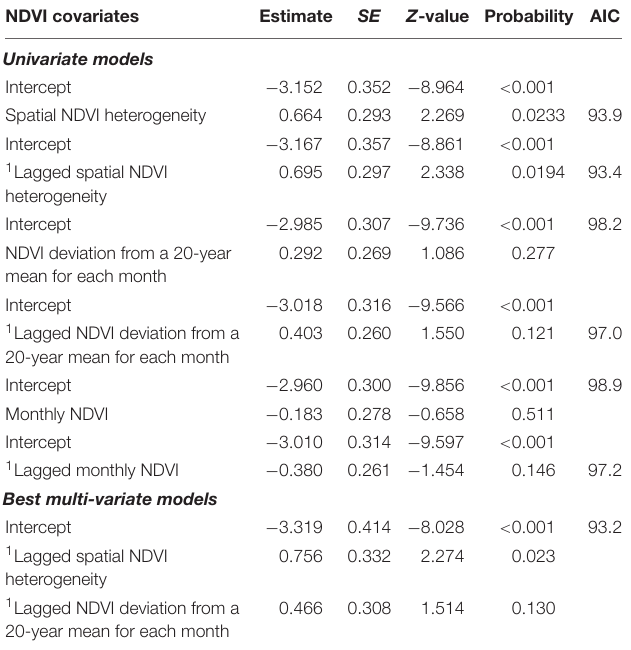
TABLE 6 | Univariate and multivariate logistic models showing the influence of NDVI metrics on the monthly occurrence of anthrax outbreaks in wildlife from LNNP, Kenya NDVI covariates Estimate